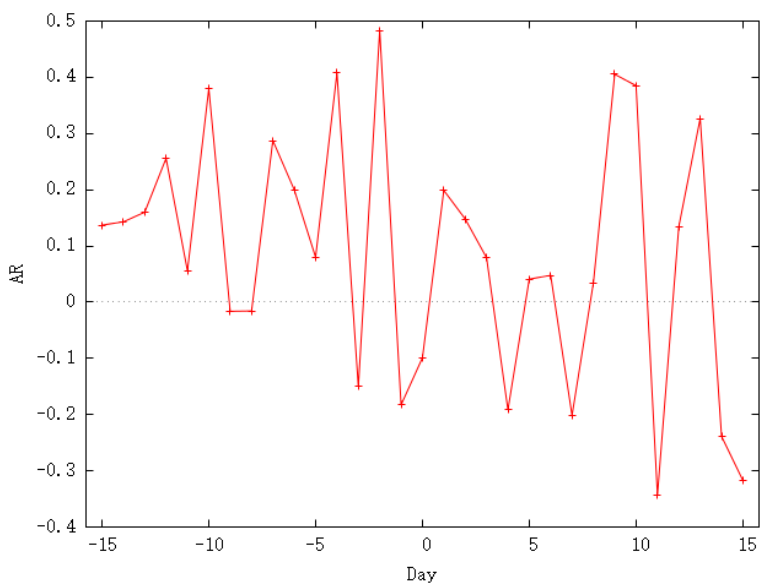
Figure 1. AR of IC design houses in patent lawsuits.